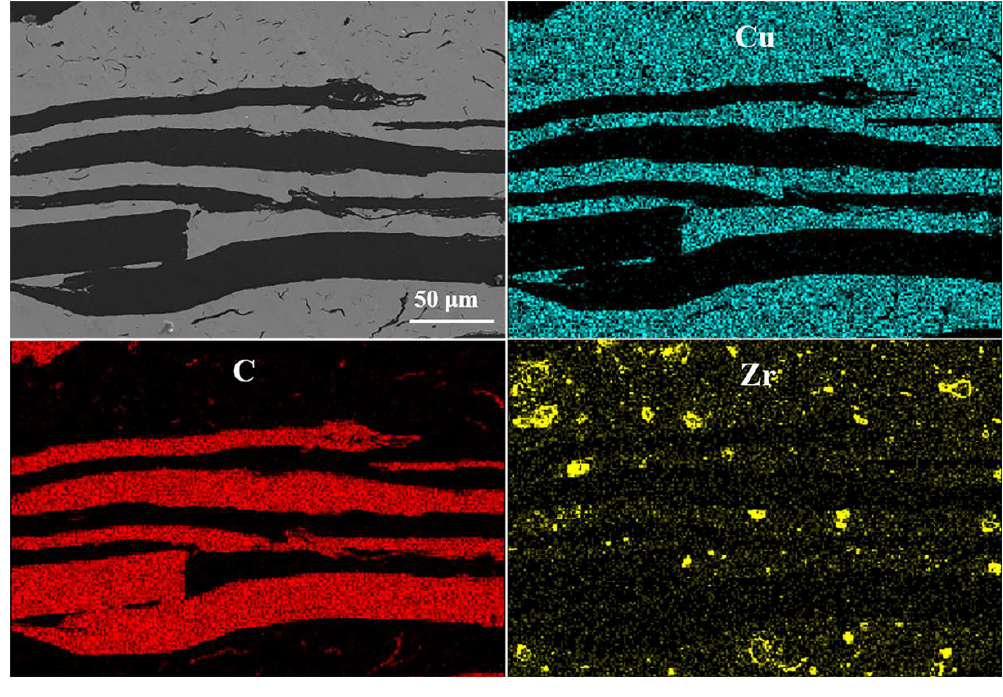
Figure 6. Element distribution mapping of FG/Cu composite with 2 wt % Zr.